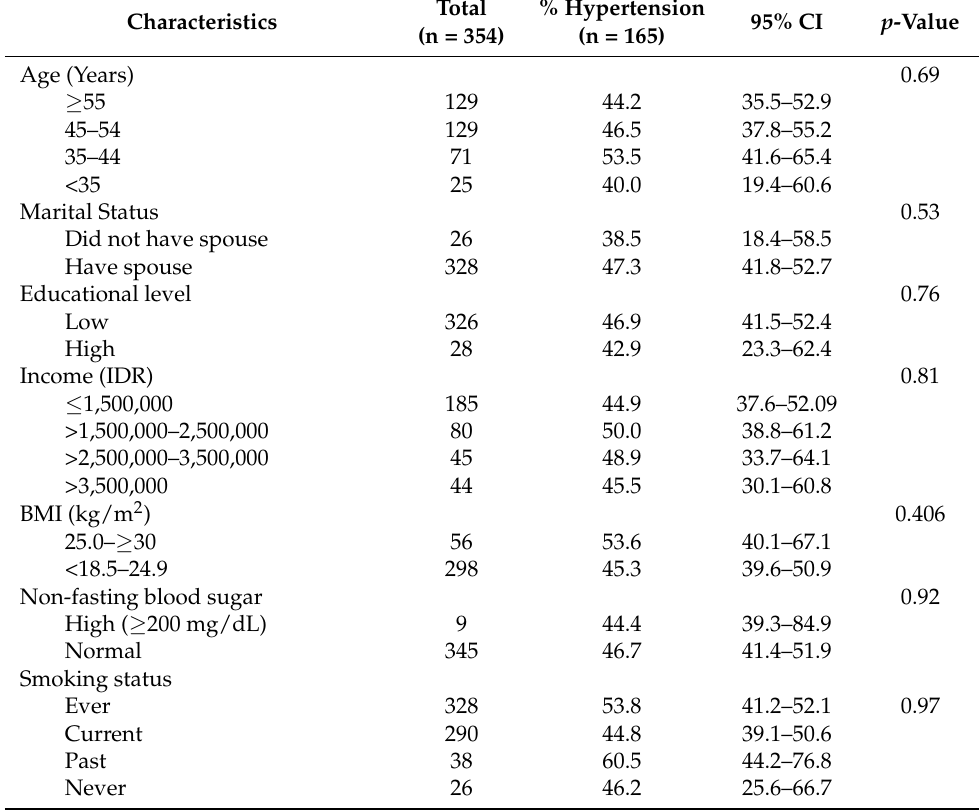
Table 2. Prevalence of hypertension based on demographical, historical diseases, lifestyle and diet characteristics in Karawang and Bogor in West Java, Indonesia